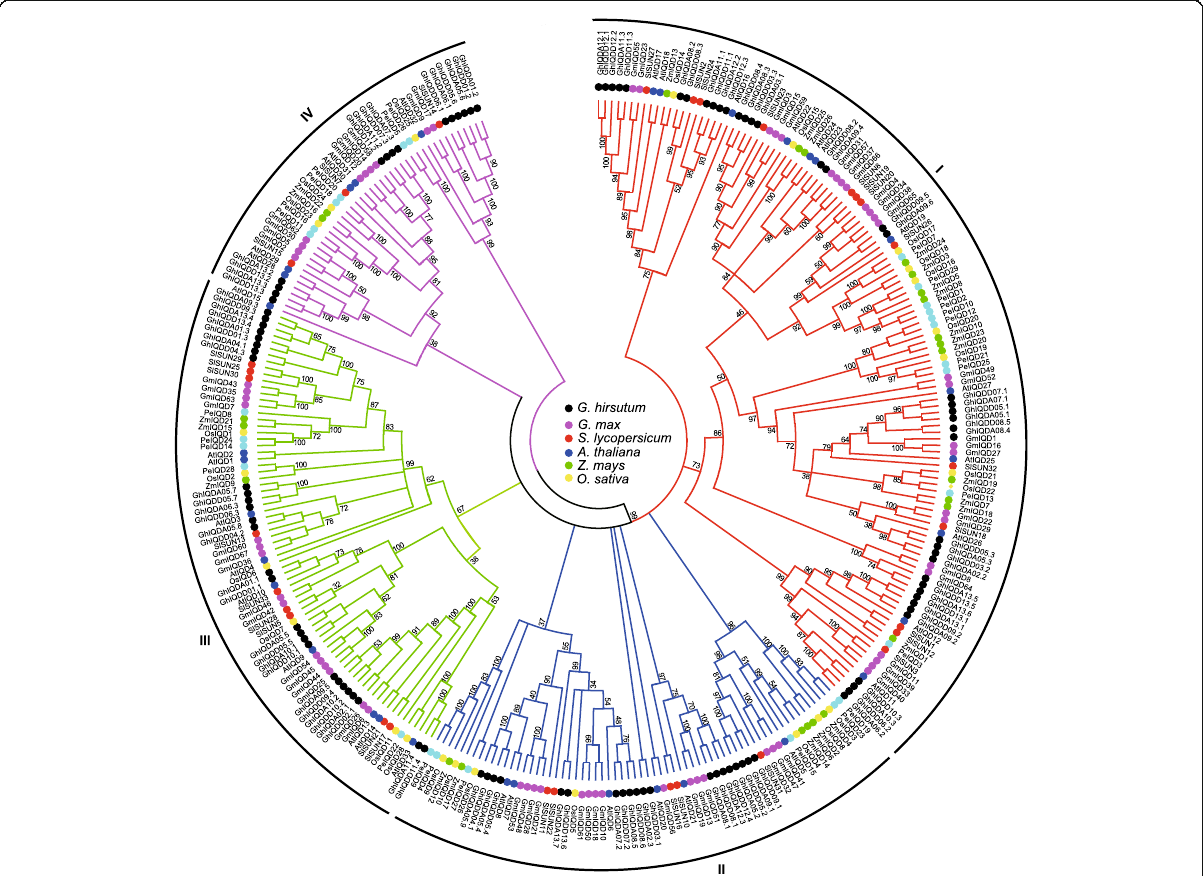
Fig. 2 Phylogenetic and evolutionary analysis of IQD proteins from different plant species. Note, green dots indicate G. hirsutum L. IQD proteins; pink dots indicate soybean IQD proteins; red dots indicate IQD proteins from tomato; blue dots indicate Arabidopsis IQD proteins . The phylogenetic tree was generated from an alignment of the IQD protein sequences using the Neighbor-joining (NJ) method in the MEGA 7 software